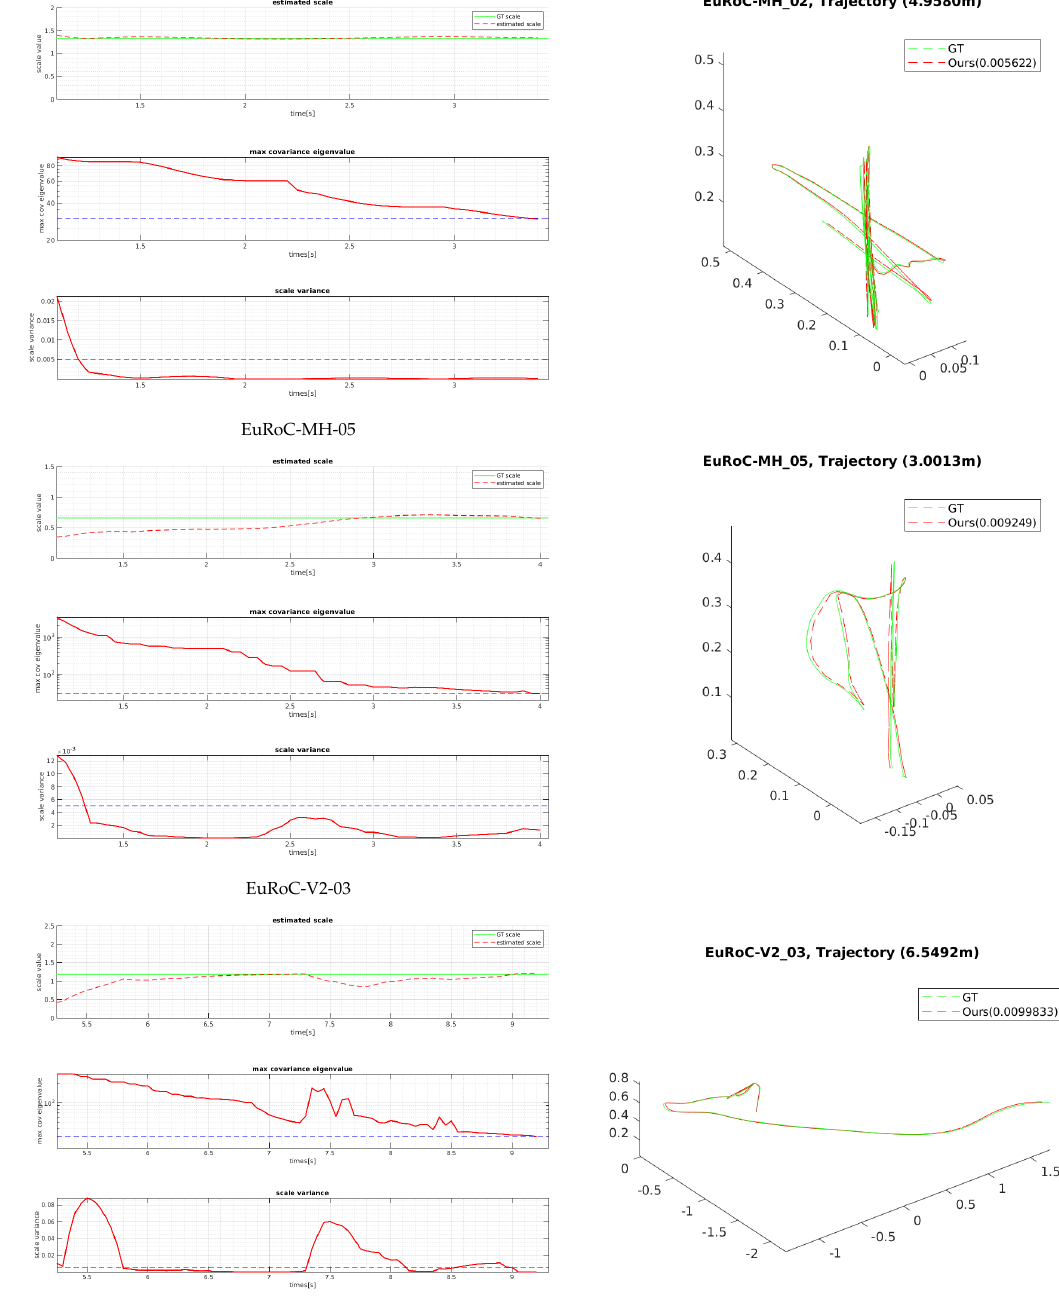
Figure 11. The scales and the two variance-based confidence metrics at the bootstrapping stage, as well as the estimated and ground-truth trajectories of three EuRoC sequences are shown. The left graphs show the estimated scale, the maximum eigenvalues of the covariance, and the variance of the scale parameter from top to bottom. When the bootstrapping starts, the uncertainty of the pose and scale is large, and it is reflected in the metrics. As more visual and inertial observations become available, the variances decrease, and the bootstrapping ends when both go below the thresholds (shown in blue dashed lines). The right 3D plots are the ground-truth (green) and estimated (red) trajectories of the initial 15-s period. Our adaptive bootstrapping successfully finishes within 5 s for the challenging EuRoC sequences, and the RMSE pose errors after 15 s are less than 0.01